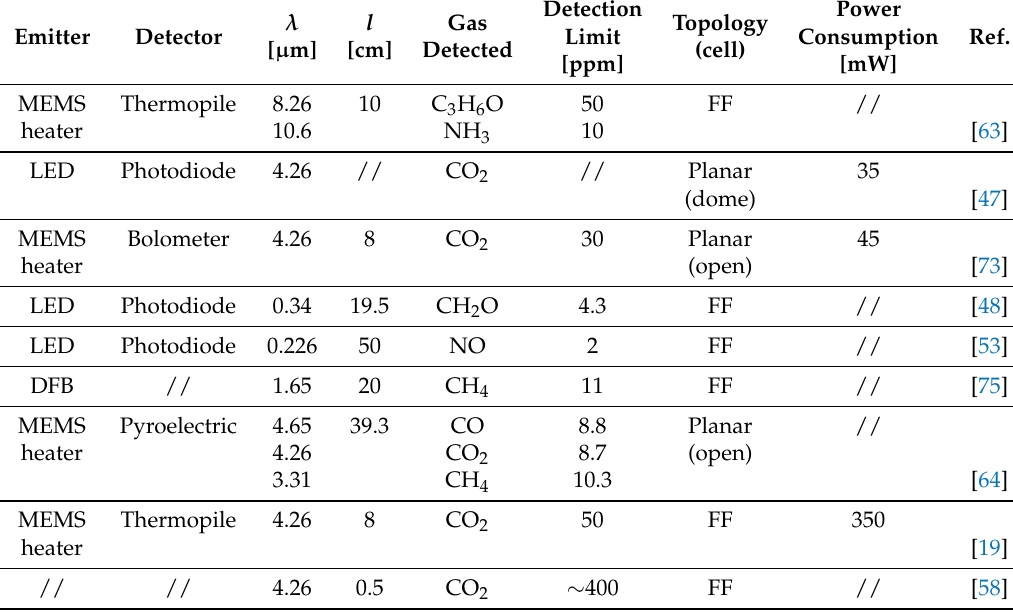
Table 1. Gas sensors based on optical detection. λ : operating wavelength; l : optical path; MEMS: micro-electro-mechanical systems; FF: face-to-face; //: unreported; LED: light emitting diode; DFB: distributed feedback laser; QCL: quantum cascade laser; MCT: mercury cadmium telluride; WG: waveguide; C 3 H 6 O: acetone; NH 3 : ammonia; CO 2 : carbon dioxide; CH 2 O: formaldehyde; NO: